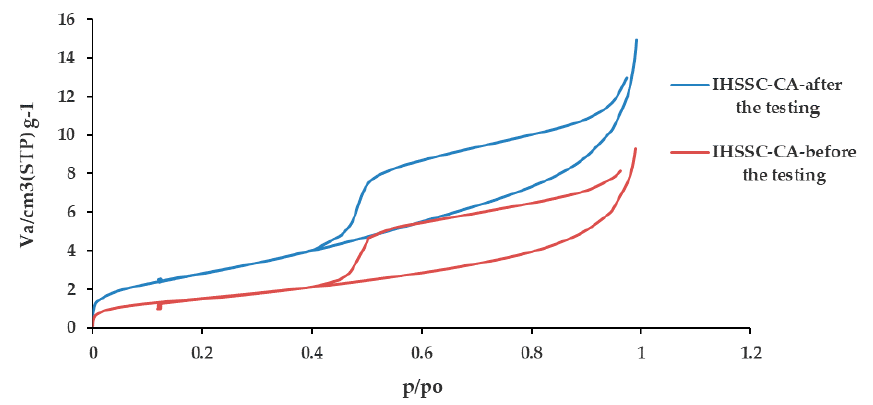
Figure 7. Nitrogen adsorption isotherms for IHSSC-CA.